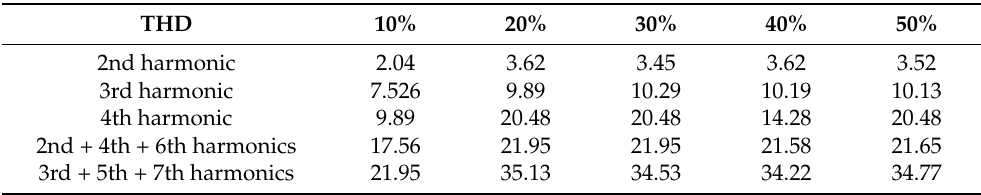
Table 5. The error of calculation THD for commercial